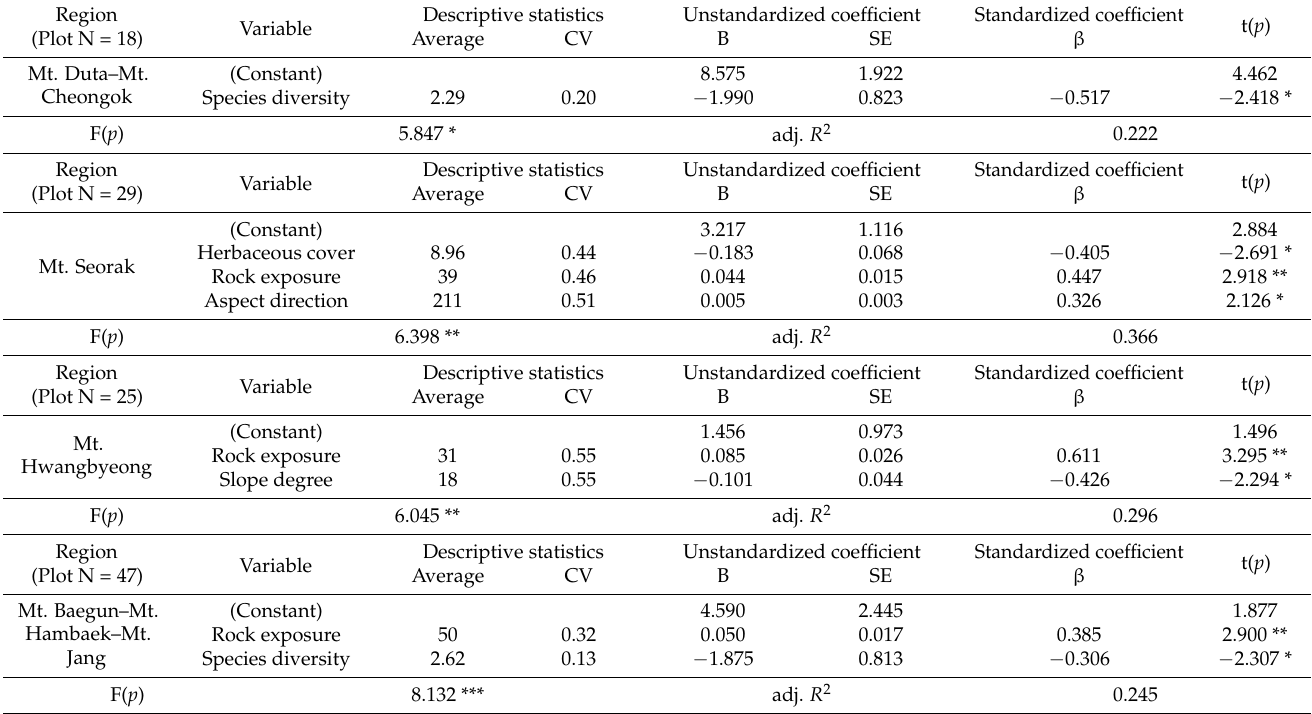
Table 6. The relationship between Abies nephrolepis young tree density and environmental